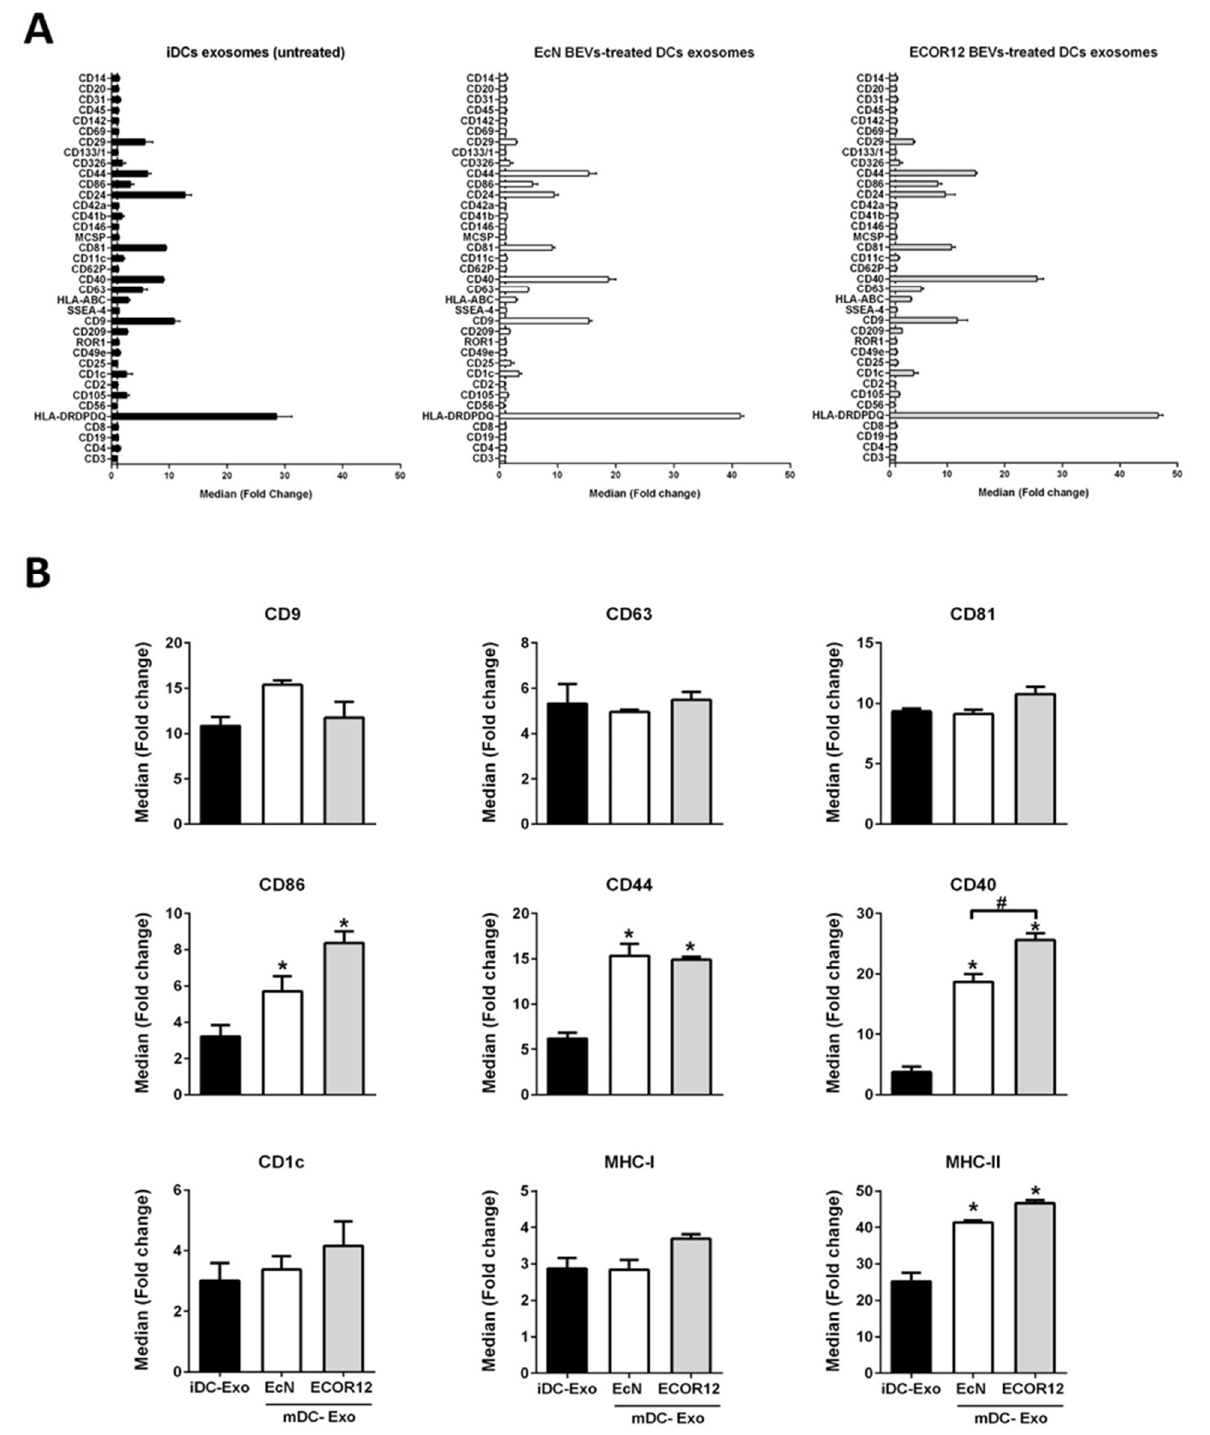
Figure 4. Extracellular vesicle surface marker values quantified by the bead-based multiplex MACSplex Exosome Human kit ( A ) and the main differences between the three subgroups ( B ): exosomes from untreated iDCs (black bars), exosomes from DCs treated with EcN vesicles (white bars) and exosomes from DCs treated with ECOR12 vesicles (grey bars). Statistical differences were assessed by one-way ANOVA followed by Tukey’s test ( p < 0.05). * Significance versus untreated control DCs, # significance between DCs stimulated with EcN or ECOR12 BEVs.